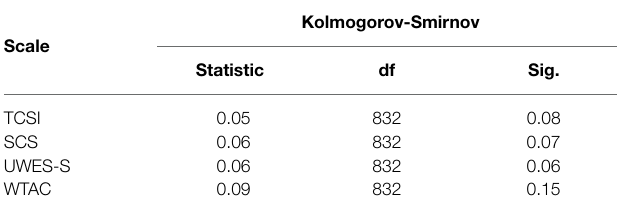
TABLE 1 | The results of K-S test.